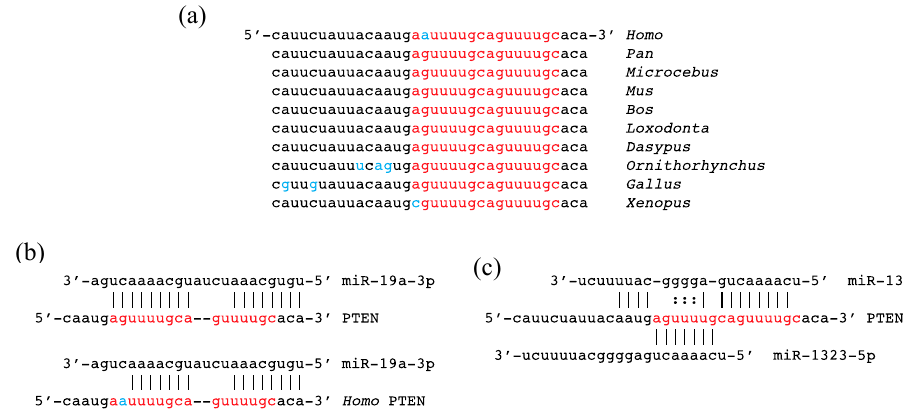
Figure 5. Predicted targeting of PTEN 3 ′ UTR by miR-19a-3p and miR-1323-5p. ( a ) Comparative sequence alignment showing AGUUUUGC repeat in red and differences from the consensus sequence in blue. ( b ) Targeting of the sequence by miR-19a-3p in chimpanzee ( above ) and human ( below ). ( c ) Two predicted targets for miR-1323-5p in the chimpanzee PTEN 3 ′ UTR. The lower target is lost from the human sequence. It already states "AGUUUUGC repeat in red.